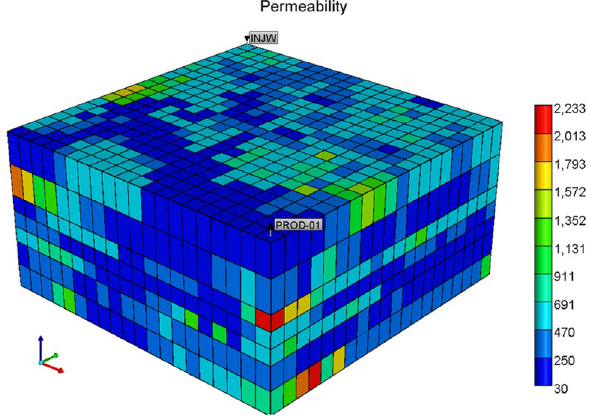
Fig. 3 Model employed, representing a region between the producer and the injector of a synthetic model of a Brazilian pre-salt field